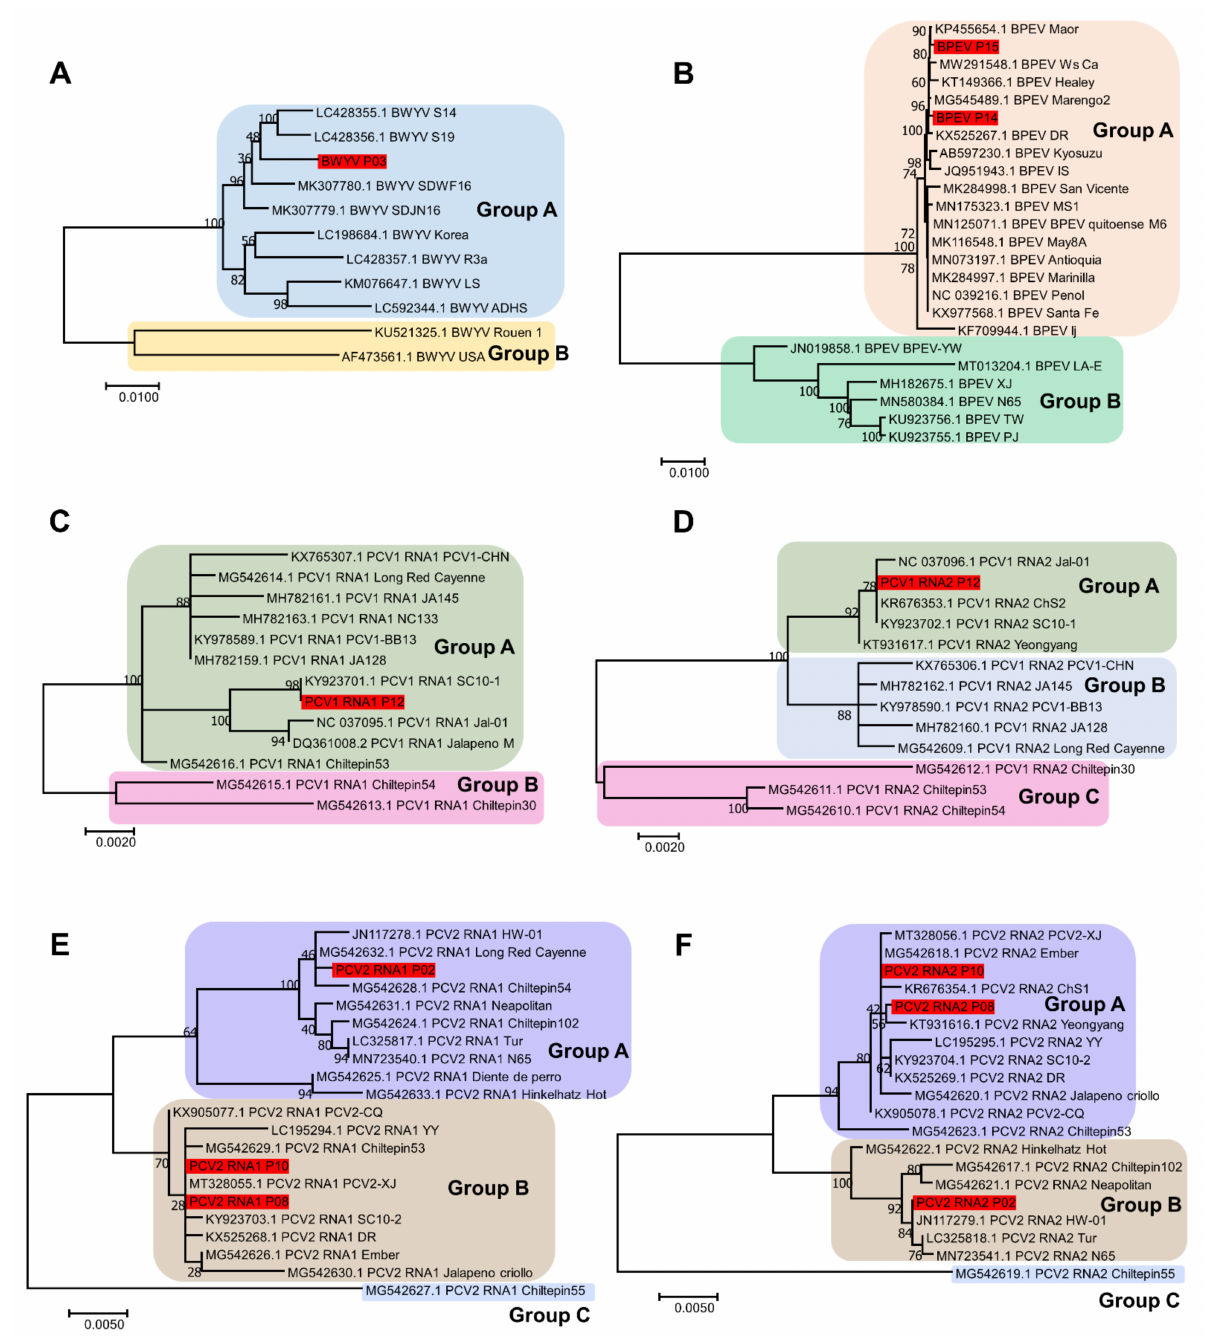
Figure 6. Phylogenetic tree of four viruses infecting pepper cultivars; BWYV, BPEV, PCV1, and PCV2: ( A ) phylogenetic tree of complete genome sequences of BWYV ( A ), BPEV ( B ), PCV1 RNA1 segment ( C ), PCV1 RNA2 segment ( D ), PCV2 RNA1 segment ( E ), and PCV2 RNA2 segment ( F ). Red-colored boxes indicate the assembled viral genome obtained from this